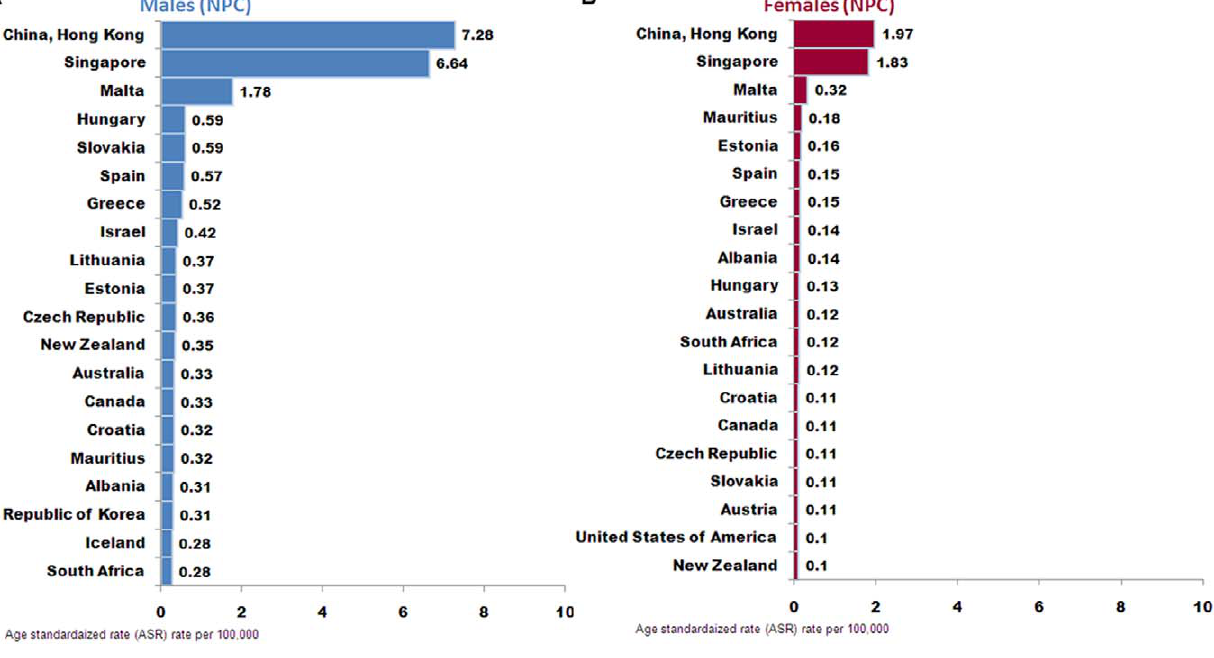
Figure 5. Regional mortality of NPC (C11) demonstrated as ASR from WHO mortality database of male (A) and female (B) populations.